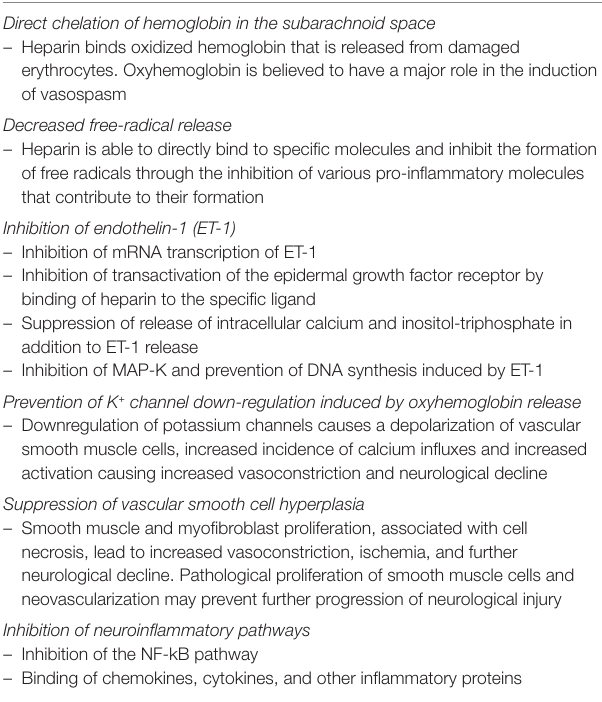
TABLe 1 | Mechanisms of action of heparin to prevent delayed neurological injury associated with subarachnoid hemorrhage.